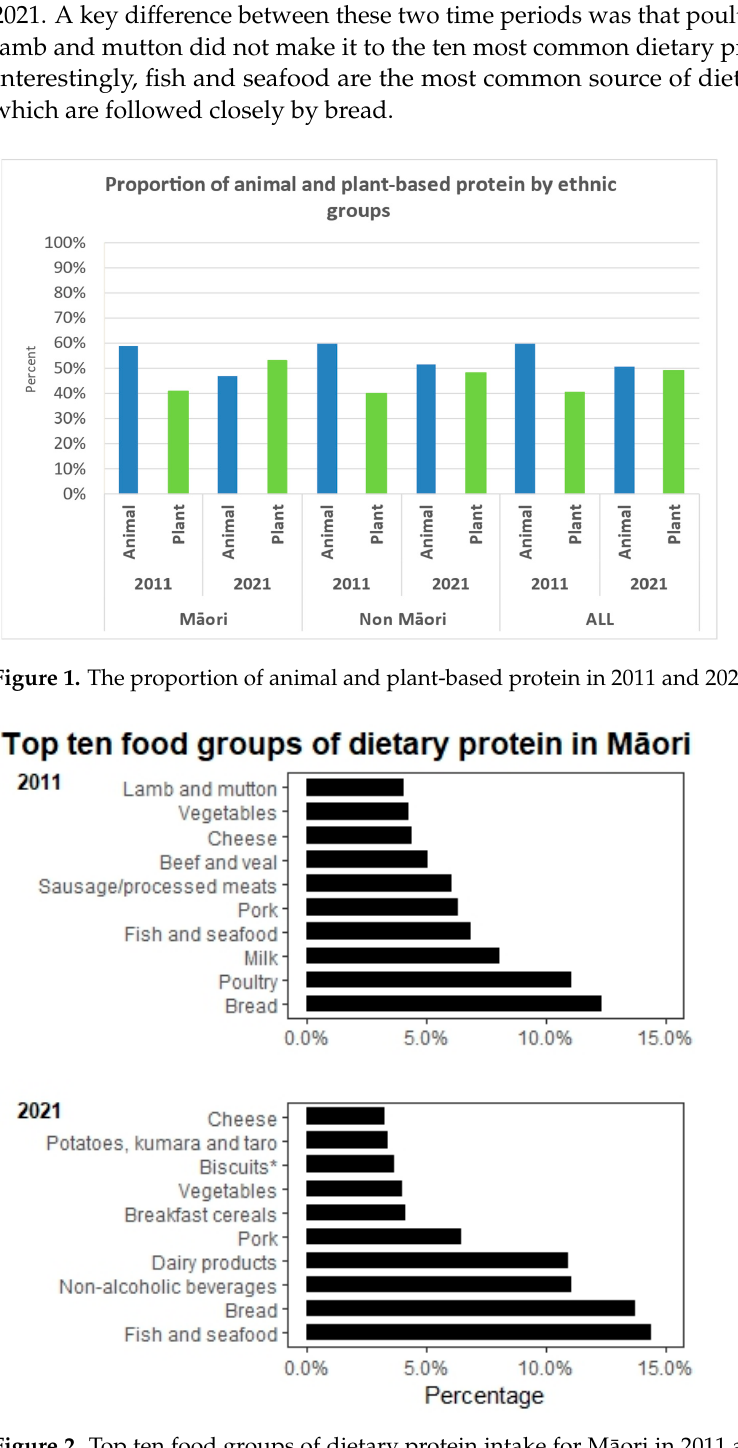
Figure 2. Top ten food groups of dietary protein intake for M¯aori in 2011 and 2021. Notes: Classi- fication of food groups were based on the 2008/09 New Zealand Adult Nutrition Survey NZ food groups. * Sweet biscuits (plain, chocolate coated, fruit fi lled, cream fi lled), crackers.